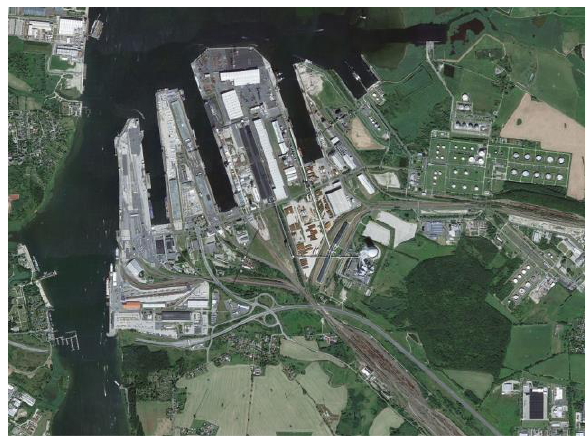
Figure 5. Rostock Port in Germany